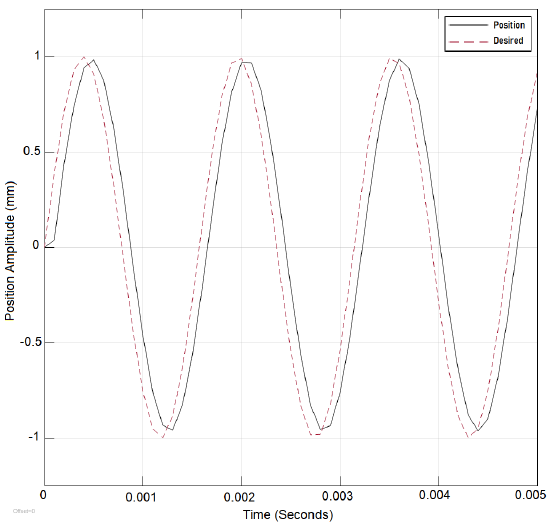
Figure 13. Deep Lyapunov controlled position with reference to sinusoidal wave of 4000 rad/s